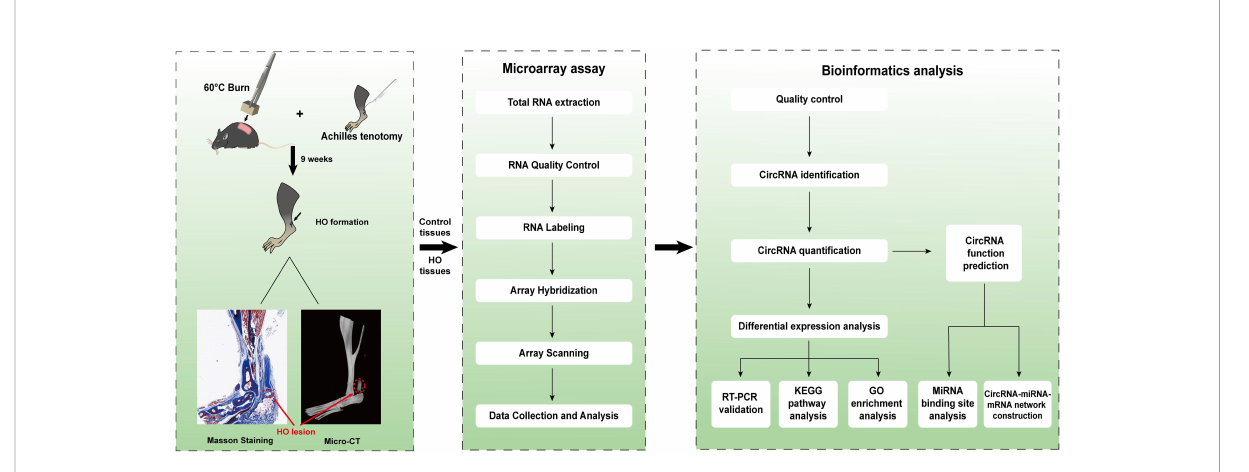
FIGURE 1 Schematic diagram of the analytical procedures used in this